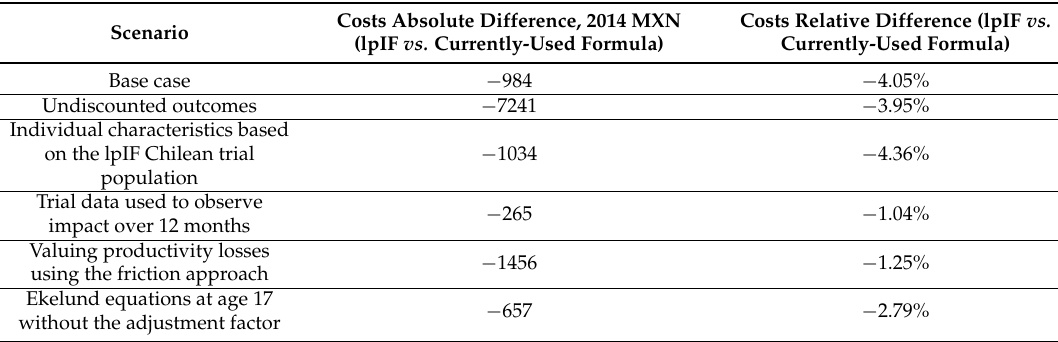
Table 5. Results of the scenario